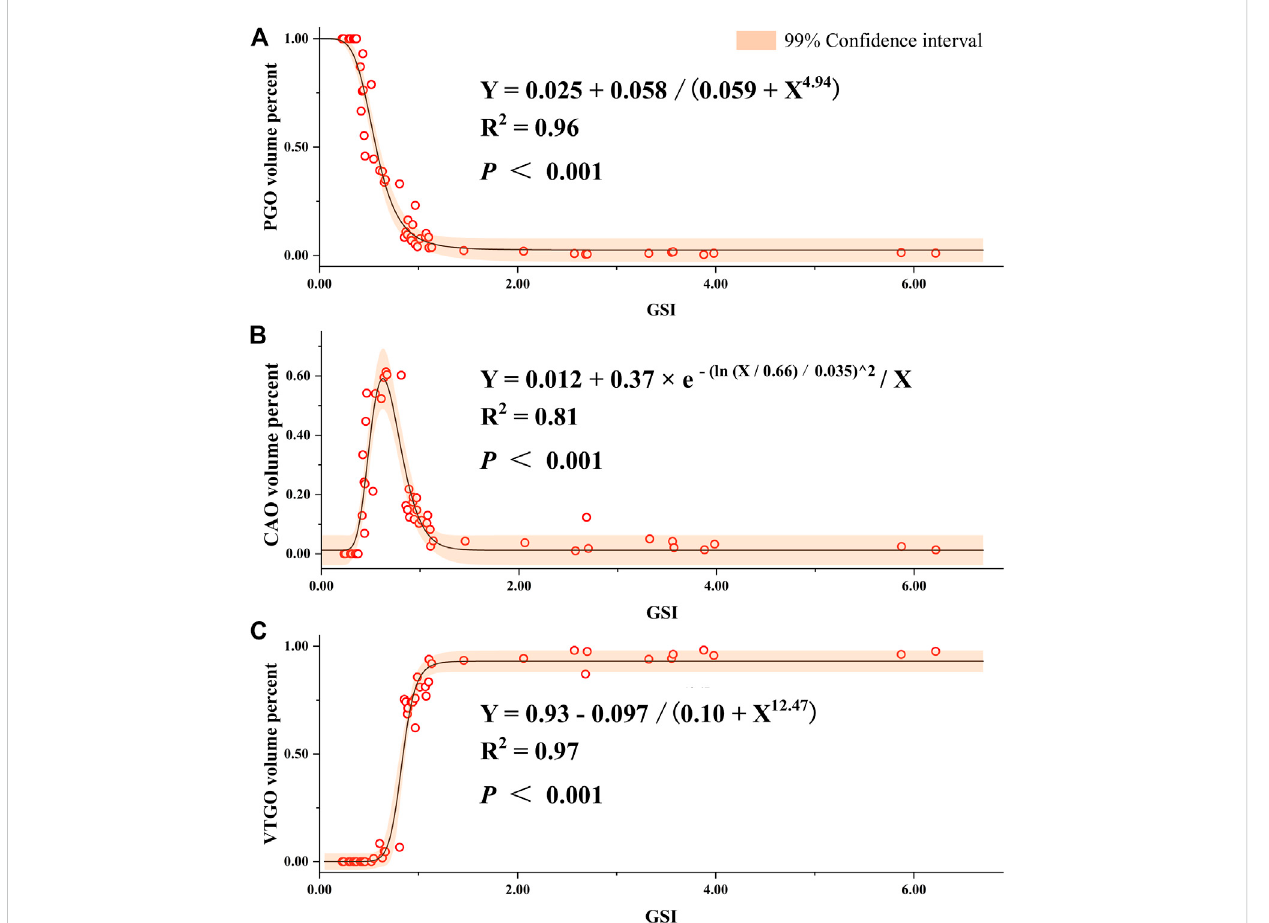
FIGURE 9 Regression of gonadosomatic index (GSI) and volume percent of different development stages of oocytes in largemouth bass. (A) Regression between the GSI and volume percent of PGO (primary growth stage oocytes) relative to the total volume of all oocytes. (B) Regression between the GSI and volume percent of CAO (cortical alveoli stage oocytes). (C) Regression between the GSI and volume percent of VTGO (vitellogenesis stage oocytes). Oocyteswereregardedasanoblateellipsoid,andthevolumeswerecalculatedusingthefollowingformula:oocytevolume= π ab 2 /6,whereaandb arethelongandshortaxesofoocytes,respectively(Shenetal.,2017;Husseinetal.,2020).Torepresentthevolumepercentofdifferentstagesofoocytes, atleastsixglassslidesweremade,andthreeslidesofovariansamplesforeach fi shweremeasured.Thenumberoffemaleindividualsfortheregressionis 55, which covers different development stages and ages (1 – 24